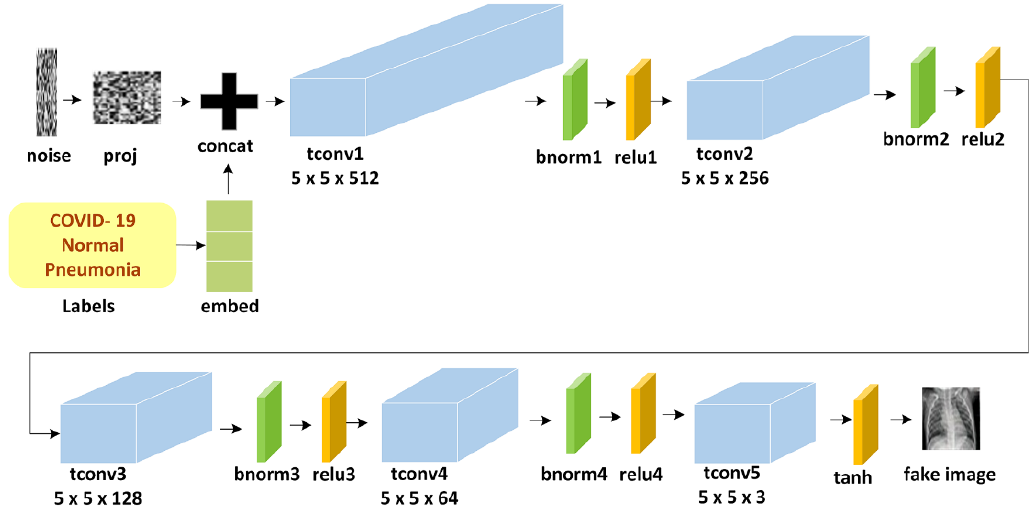
Figure 4. The proposed architecture of the CGAN generator. The generator takes a noise vector and image labels and up-samples the generated images using five transposed convolutional layers.